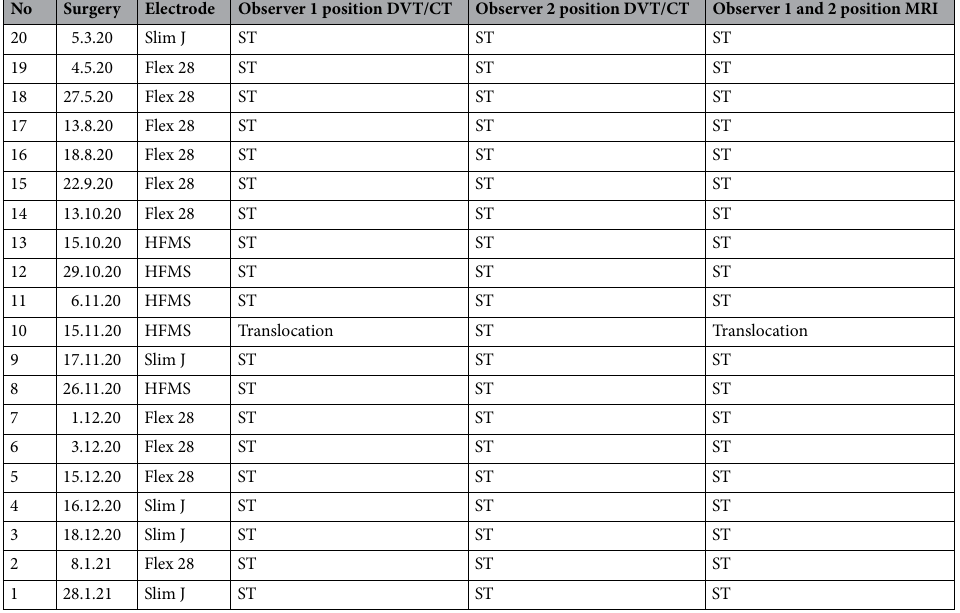
Table 1. Individual surgery date, electrode and estimated position by observer 1 and 2 for DVT/CT and